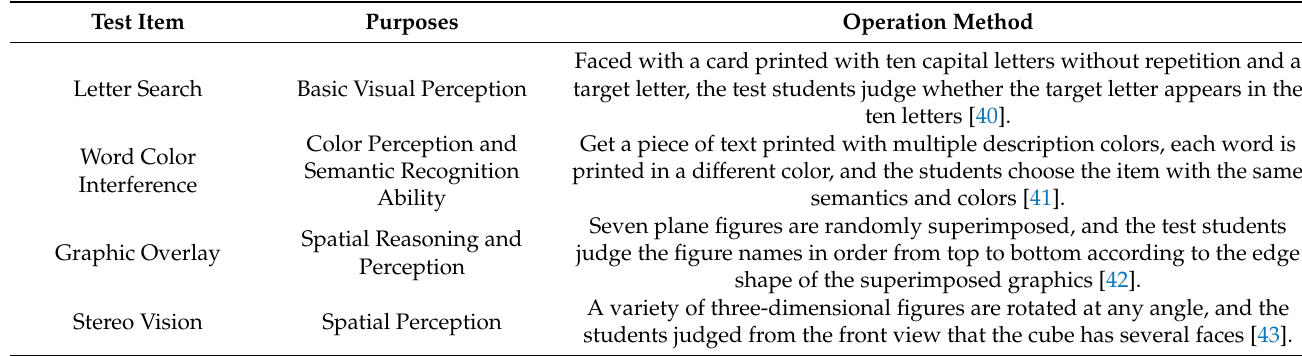
Table A2. The corresponding methods of operation for main test